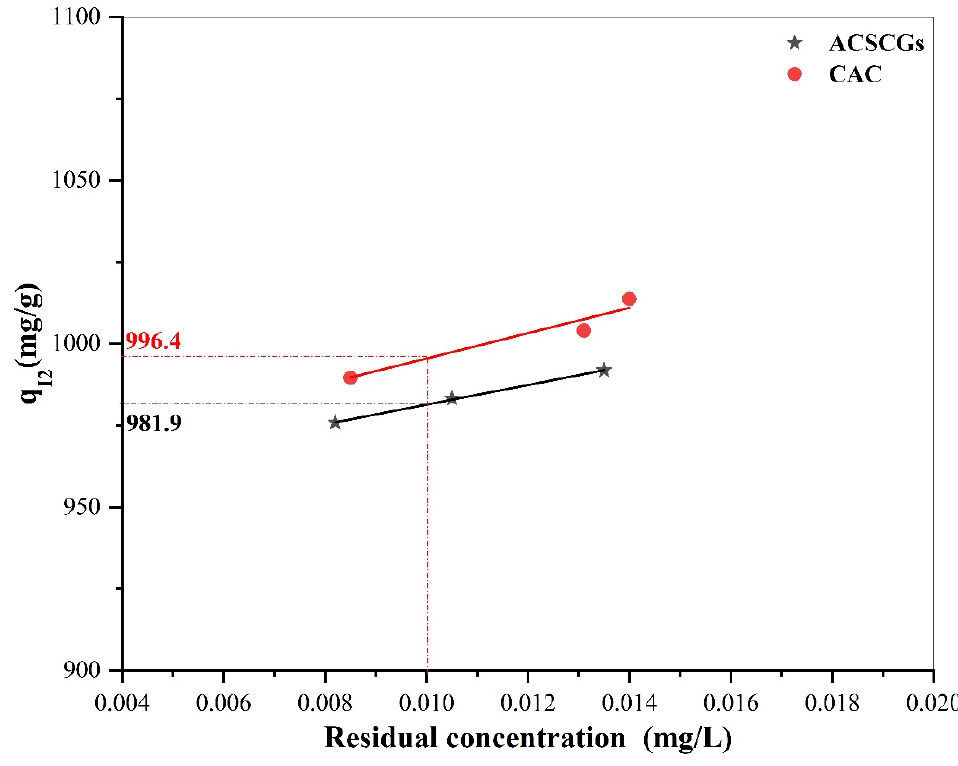
Figure 7. Adsorption isotherm of iodine on the two activated carbons.